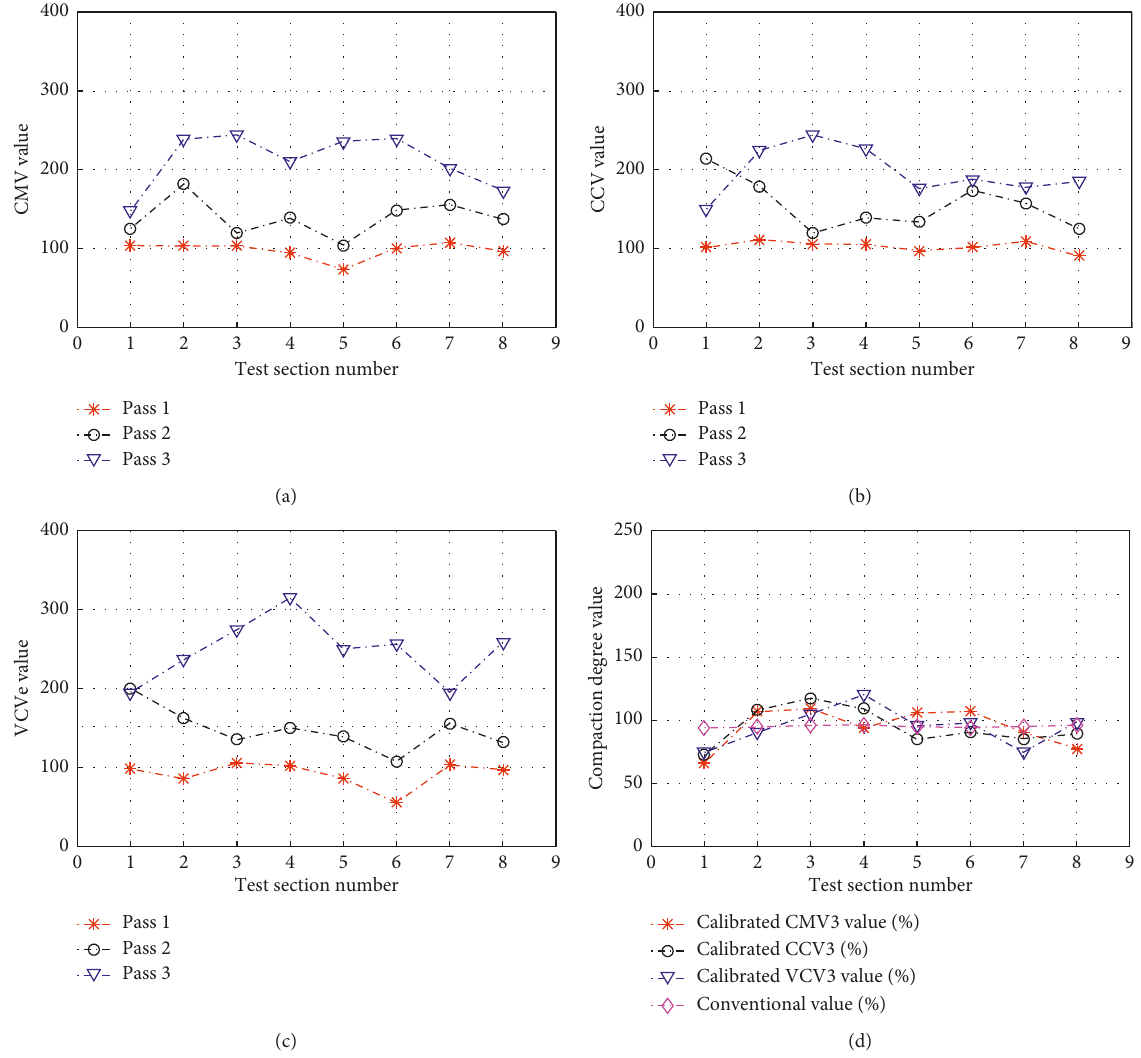
Figure 7: Variations of compaction degree values. (a) CMV variation at different rolling passes. (b) CCV variation at different rolling passes. (c) VCV e variation at different rolling passes. (d) Comparison of compaction